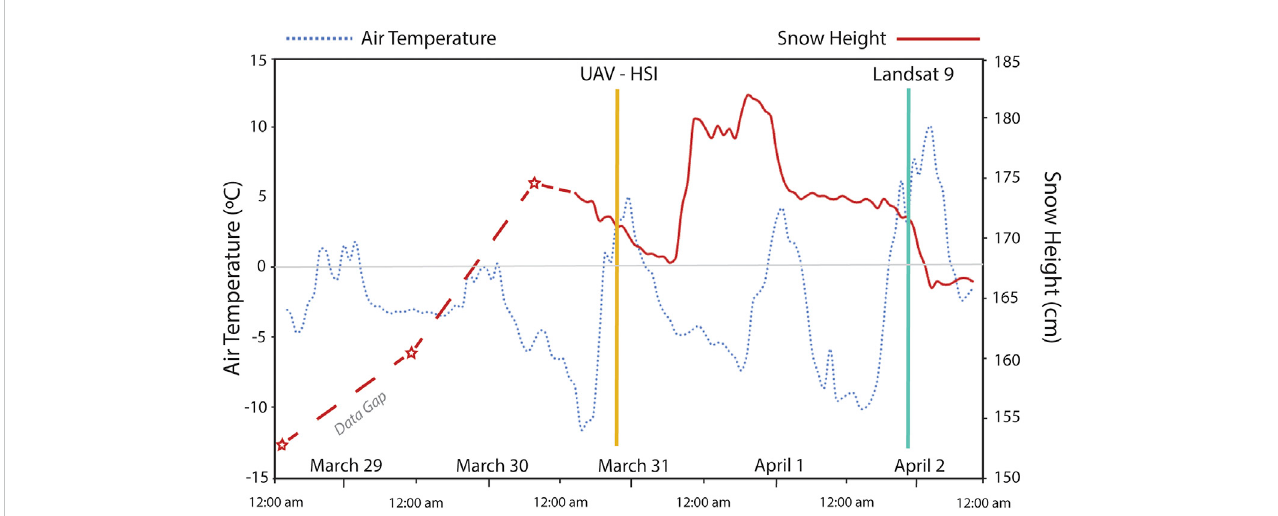
FIGURE 6 Swamp Angel Study Plot air temperature and snow height between March 29 and April 2. The gap in snow height during the storm prior to March 31st shows midnight values, as red stars, from a nearby SNOTEL